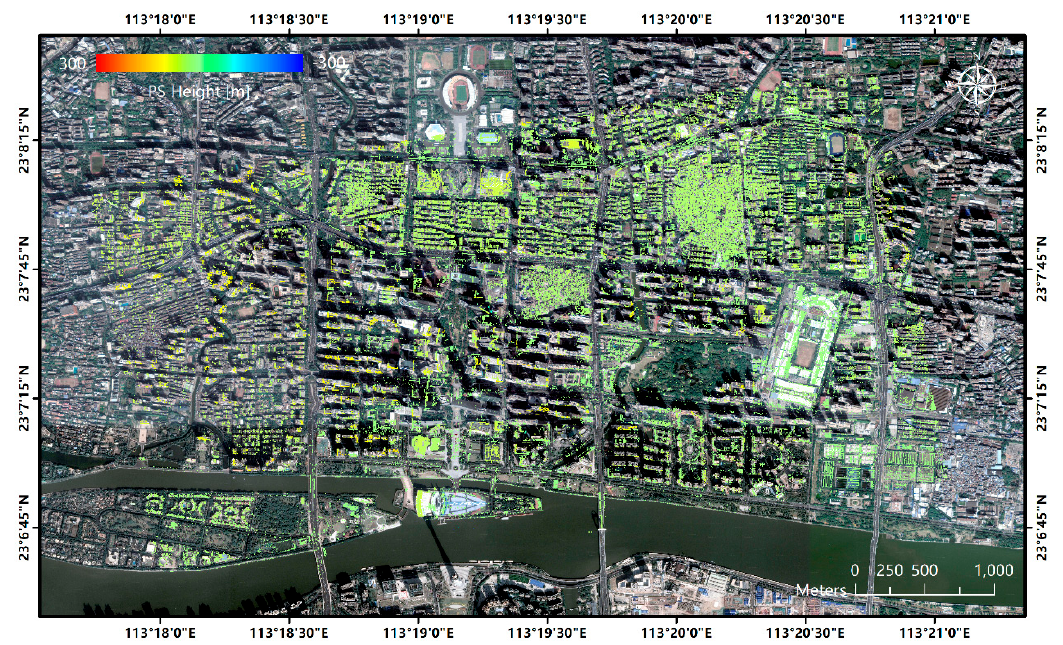
Figure 6. Residual height map for pursuit monostatic (PM) data in Guangzhou using the standard PS-InSAR method.